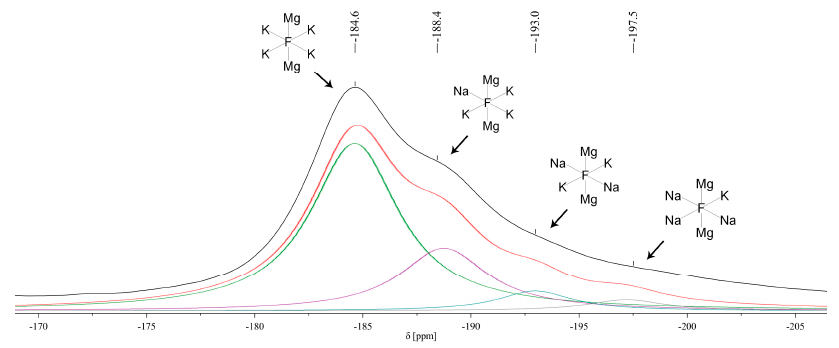
Figure 7. 19 F MAS NMR of xerogel 17, dmfit analysis and corresponding fluorine sites [16]. Table 5. 19 F MAS NMR signals of xerogel 17 by dmfit simulation [16].